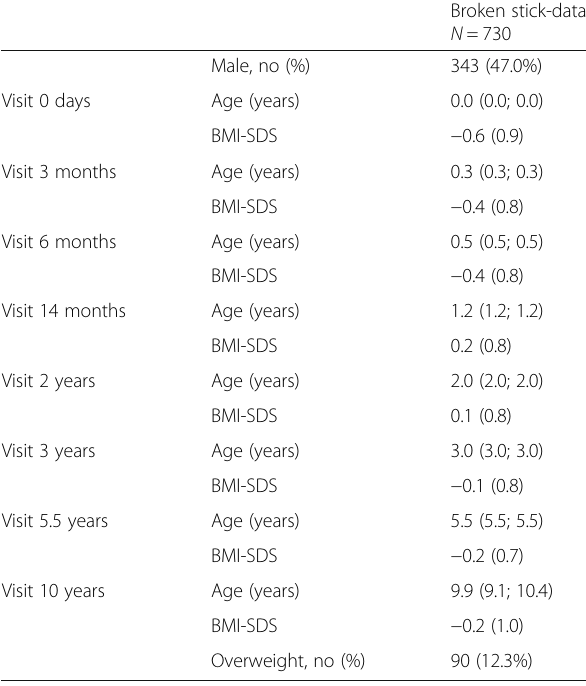
Table 1 Characteristics of the population for analysis